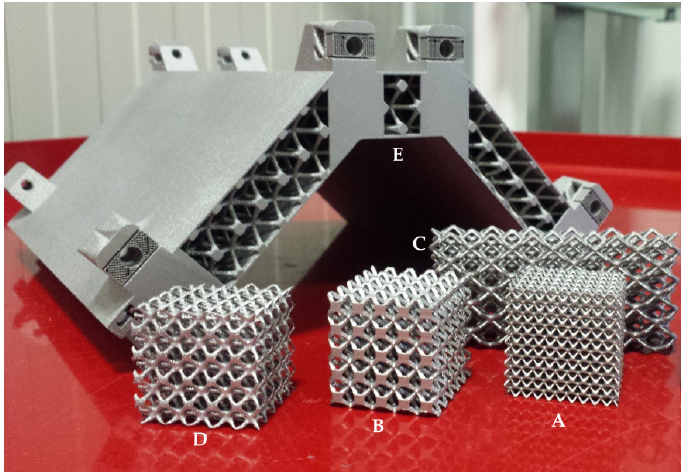
Figure 6. Manufacturability verification carried out on investigated cells: 5 × 5 × 8 (A), 10 × 10 × 16.5 (B), 20 × 10 × 25 (C), 11 × 11 × 16.5 (D) and prototype (E).